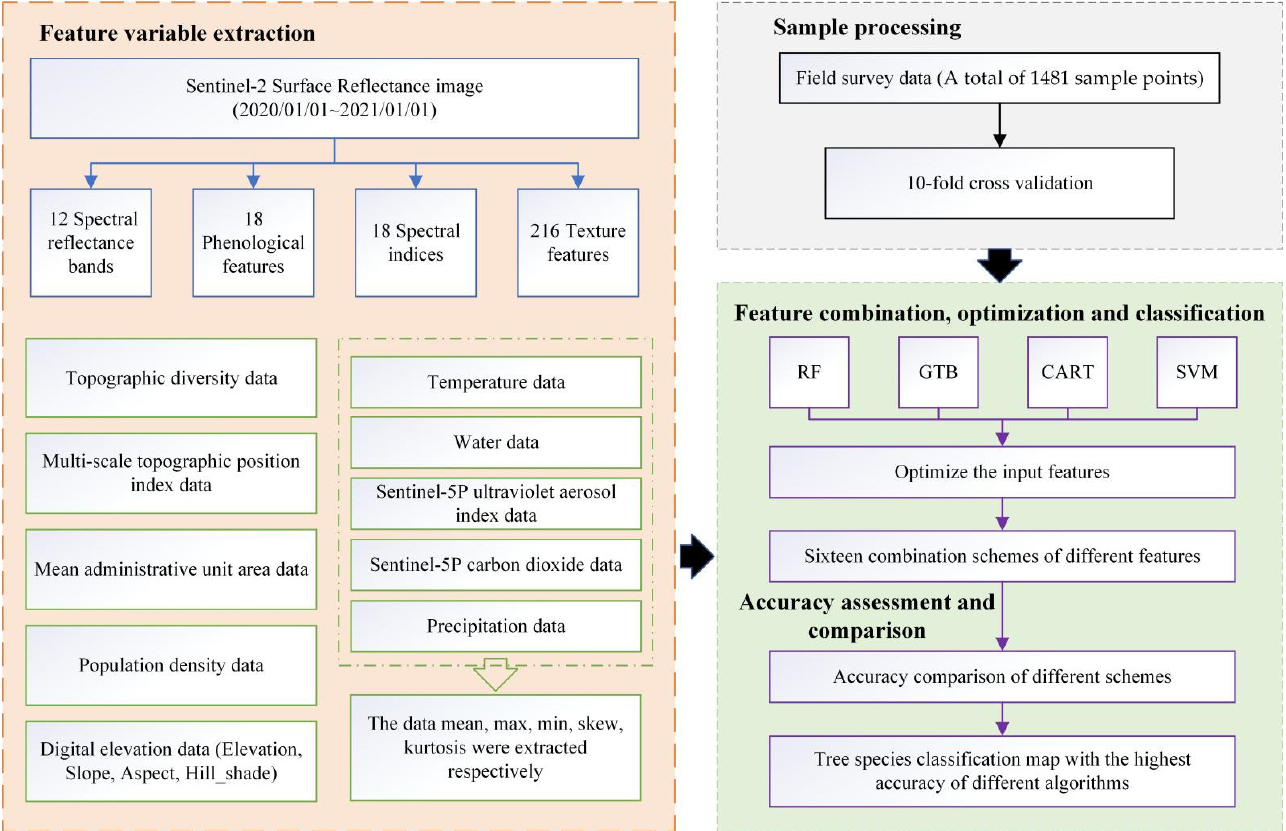
Figure 2. The flowchart used in this study.